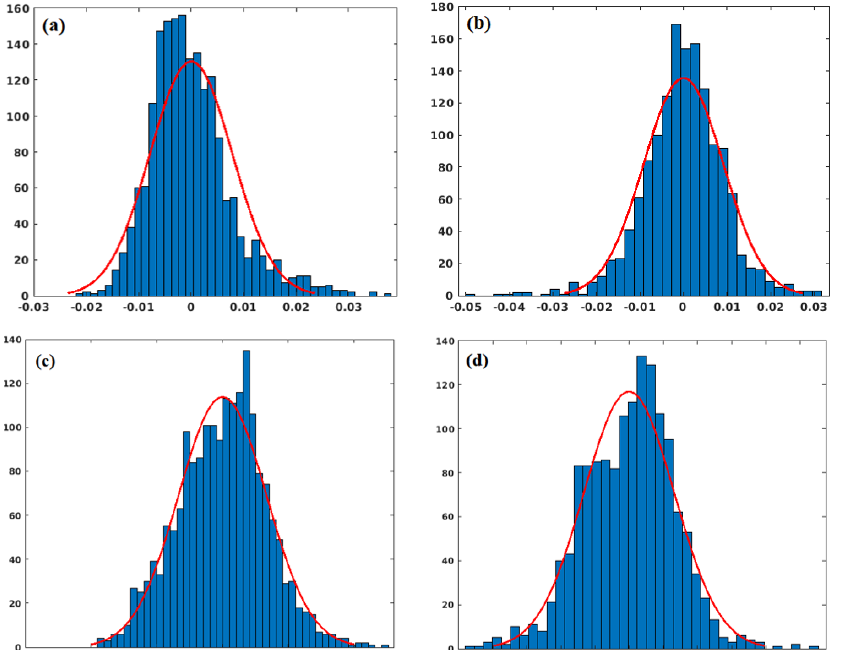
Figure 9. Histograms of residual frequency distributions: ( a , b ) indicate the ascending and descending residual distributions between the time–series InSAR–based deformation and its inversion–fitted model values, respectively; and ( c , d ) indicate the ascending and descending residual distributions between the D–InSAR–extracted deformation and its inversion-fitted model values, respectively.